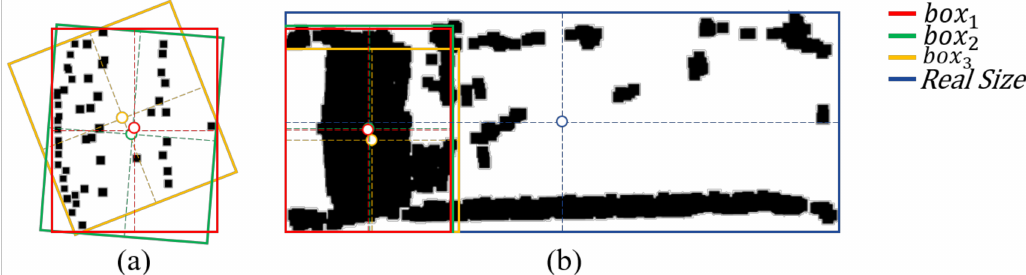
Figure 25. The influence of point cloud on the shape and position estimation results: ( a ) The three pose estimation results when the point cloud is partly missing. ( b ) The comparison of estimation results and ground truth. Due to the missing part of the point cloud, the three methods’ shape and position estimation results are very close. Although the box 1 has the best heading estimation, there is a deviation of shape and position